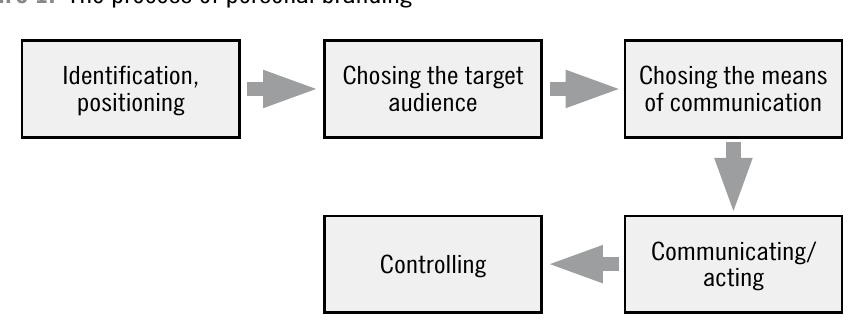
Figure 1. The process of personal branding